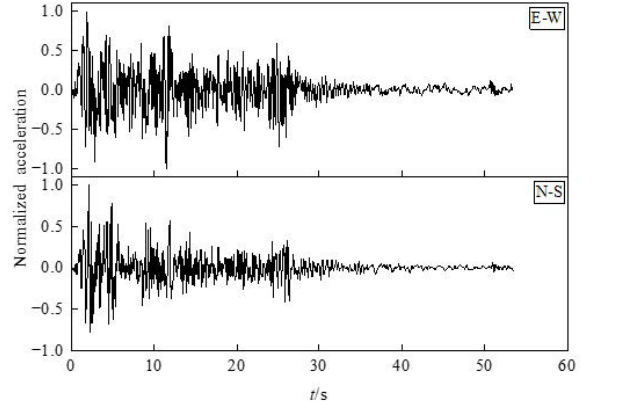
Table 3. Test cases.